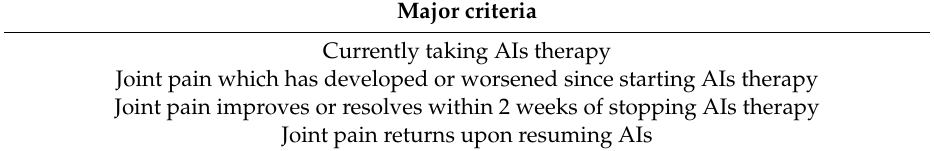
Table 1. Definition of Aromatase Inhibitors-induced Arthralgia (AIA) according to Niravatah et al. [10] Major